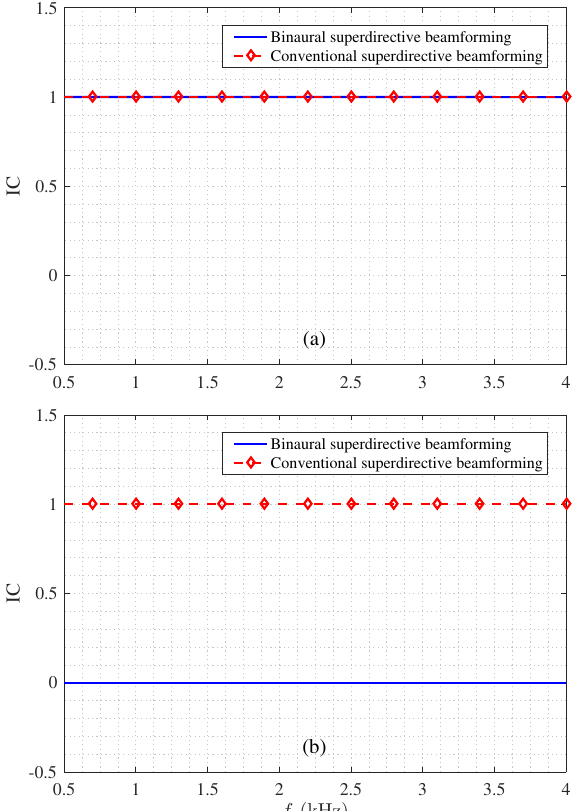
Figure 7. Magnitude of the output ICs: ( a ) diffuse noise and ( b ) white noise. Conditions of simulation: M = 8 for the binaural superdirective beamformer, M = 3 for the conventional superdirective beam- former, and δ = 1 cm. Note that the output IC of the binaural superdirective beamformer in diffuse noise is frequency-dependent; it approaches 1 under 4 kHz but decreases as the frequency